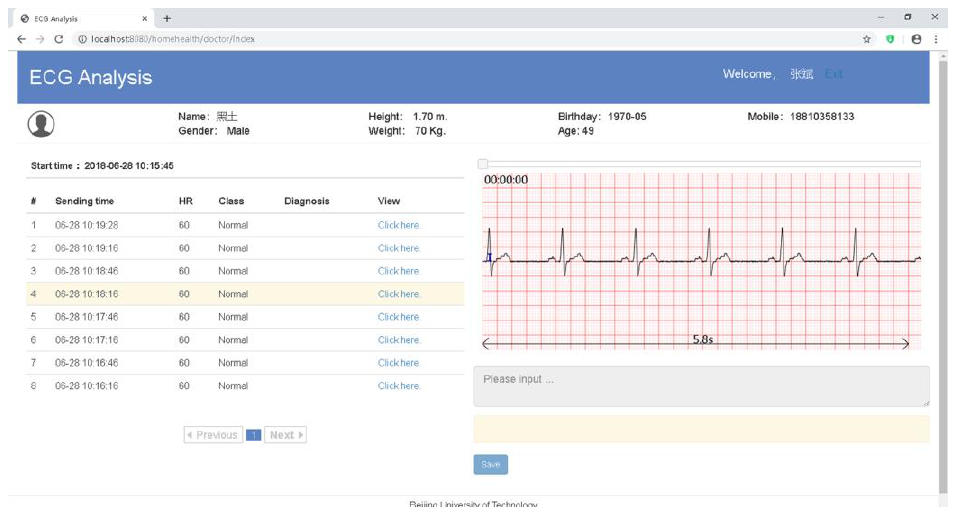
Figure 7. The main web page of the web application.